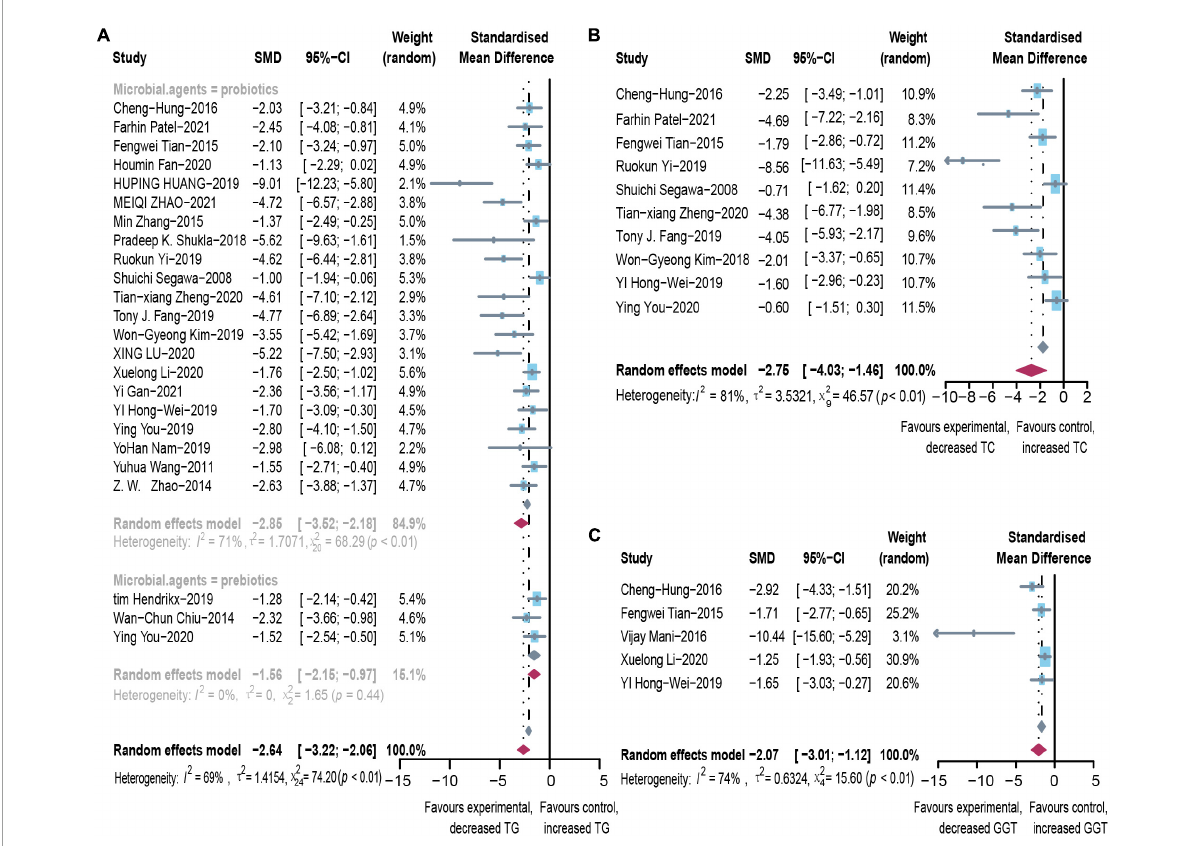
FIGURE2 Effectiveness of microbial agents on lipid index. (A) The effect of microbial agents on TG, (B) TC. (C) The effect of microbial agents on GGT. SMD, Standardized mean difference; CI, Confidence